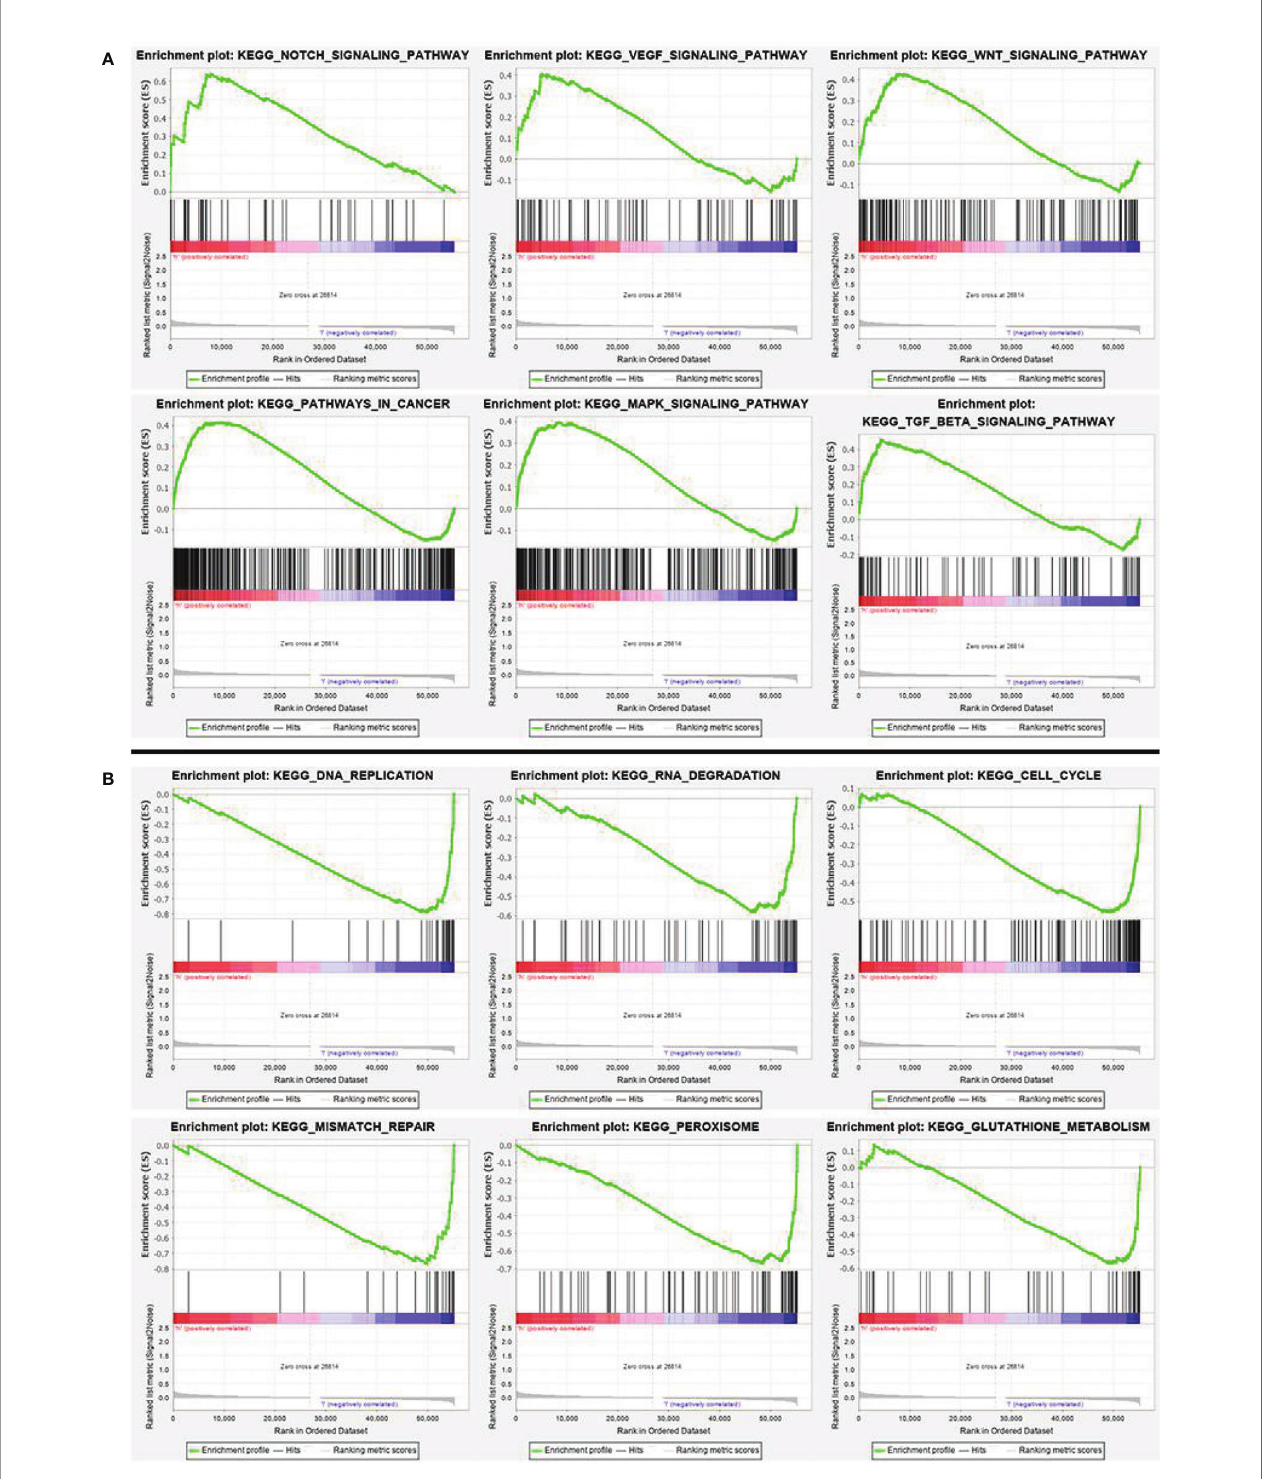
FIGURE 6 | (A) GSEA analysis of main enriched pathways in the high-risk group. (B) GSEA analysis of main enriched pathways in the low-risk